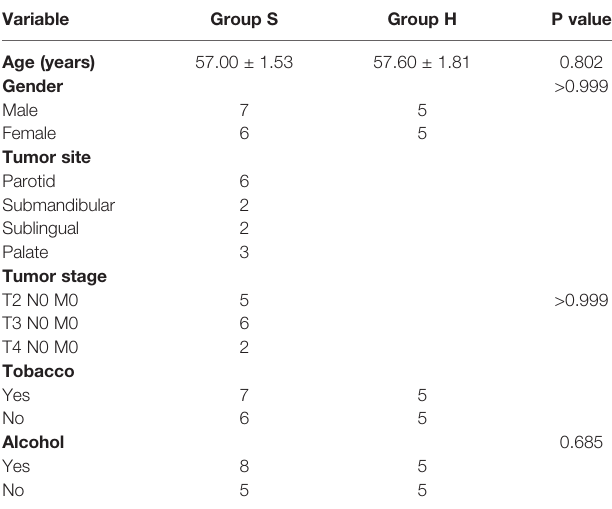
TABLE 1 | The demographic data of